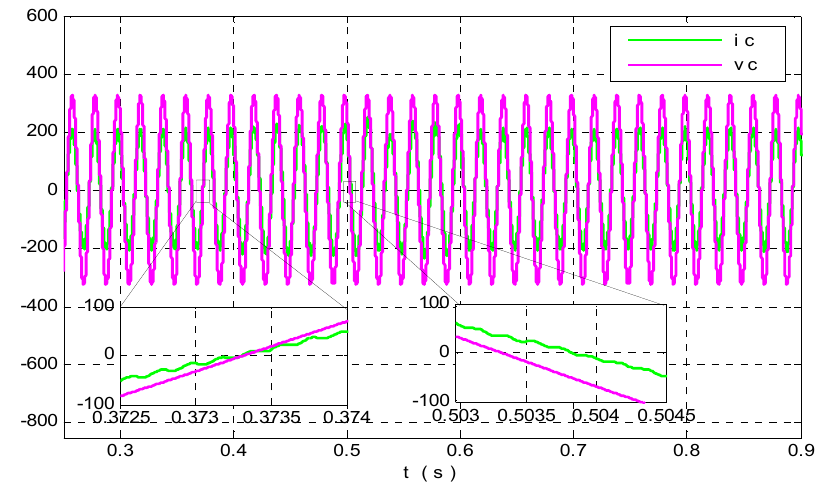
Figure 27. Voltage and current signals (phase b).